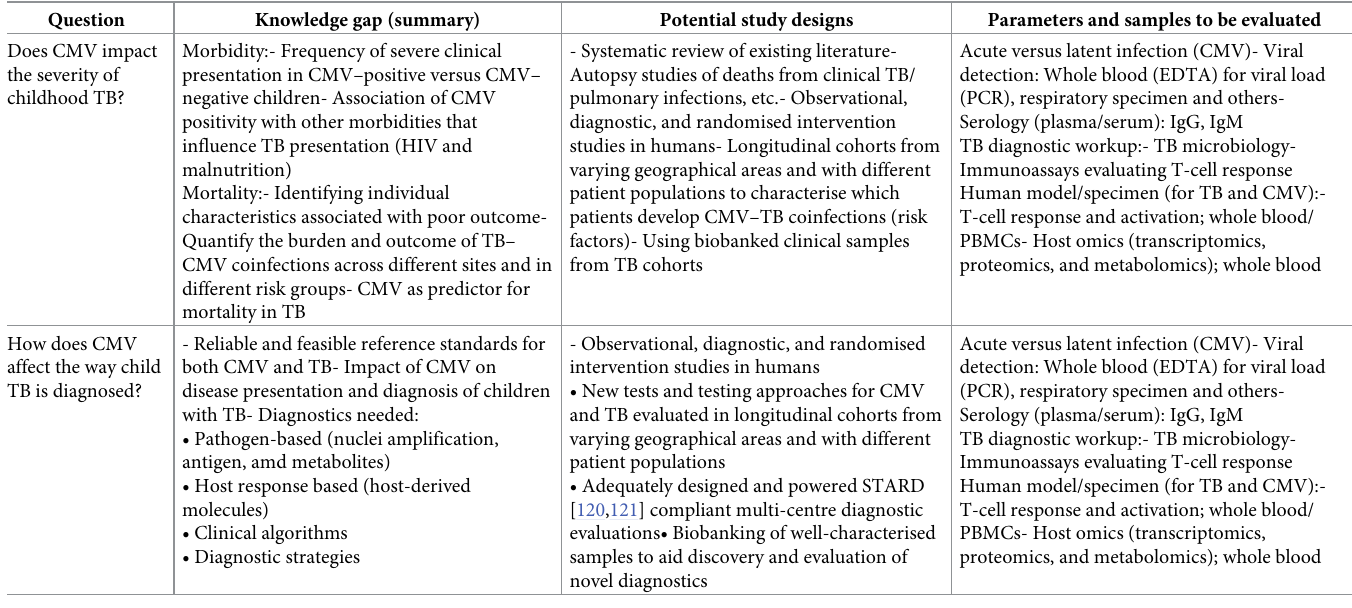
Table 4. Understanding the clinical impact of CMV–TB